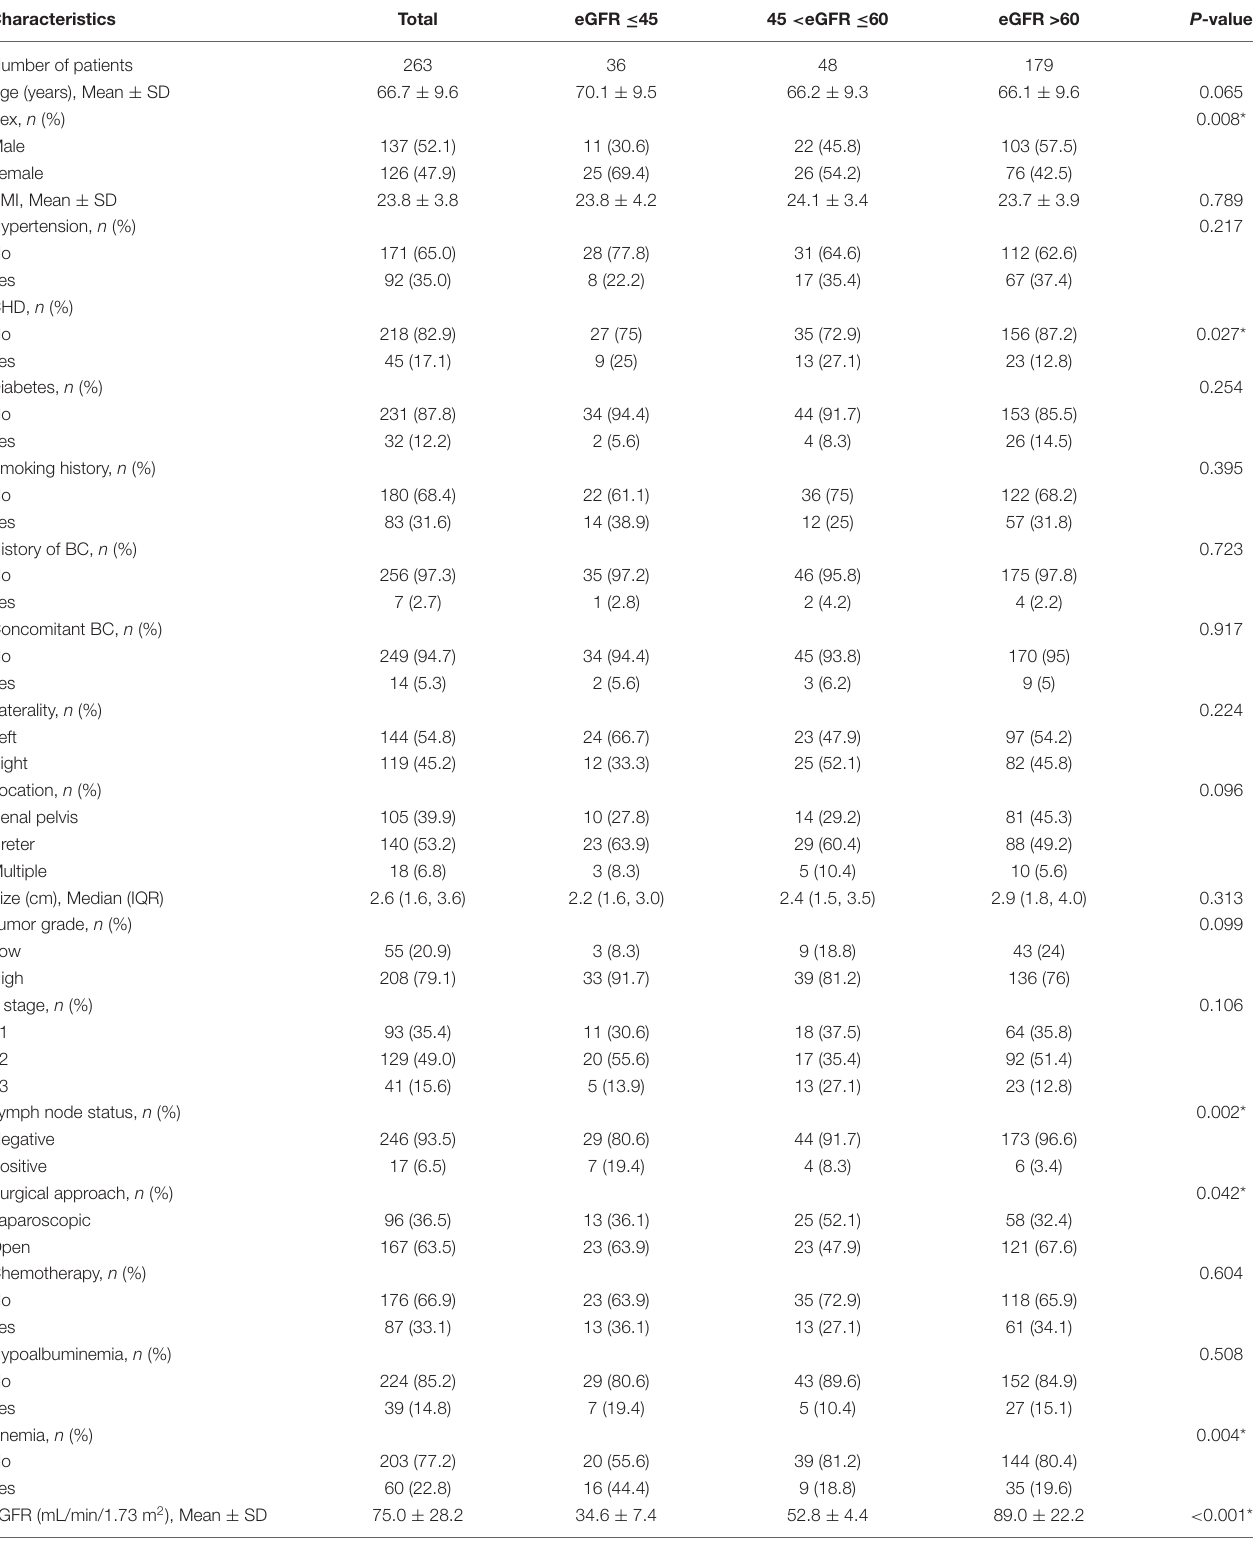
TABLE 1 | The relationship between eGFR groups and clinicopathological parameters in the UTUC cohort ( n = 263).